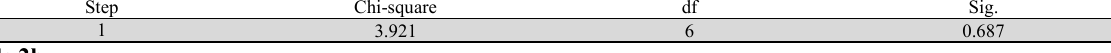
Hosmer and Lemeshow Test